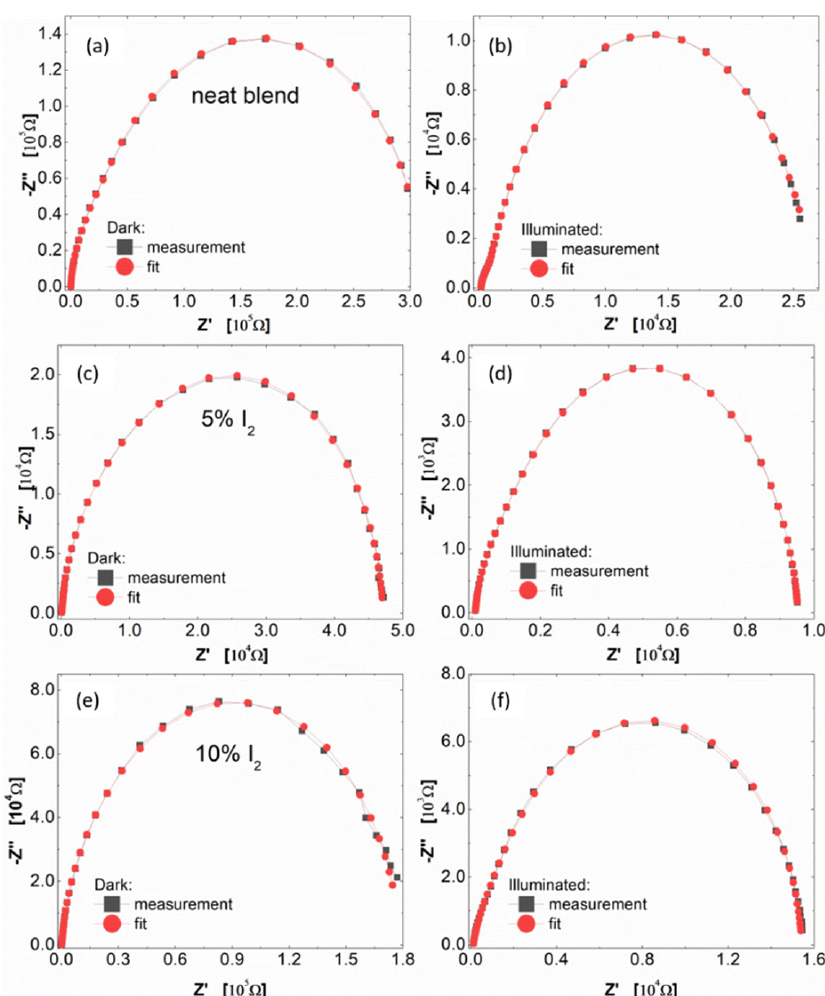
Figure 10. Electrochemical impedance spectra of standard organic solar cells (left side—in dark; right side -illuminated) with the active layer ( a , b ) undoped; ( c , d ) 5% ( e , f ) 10% iodine.